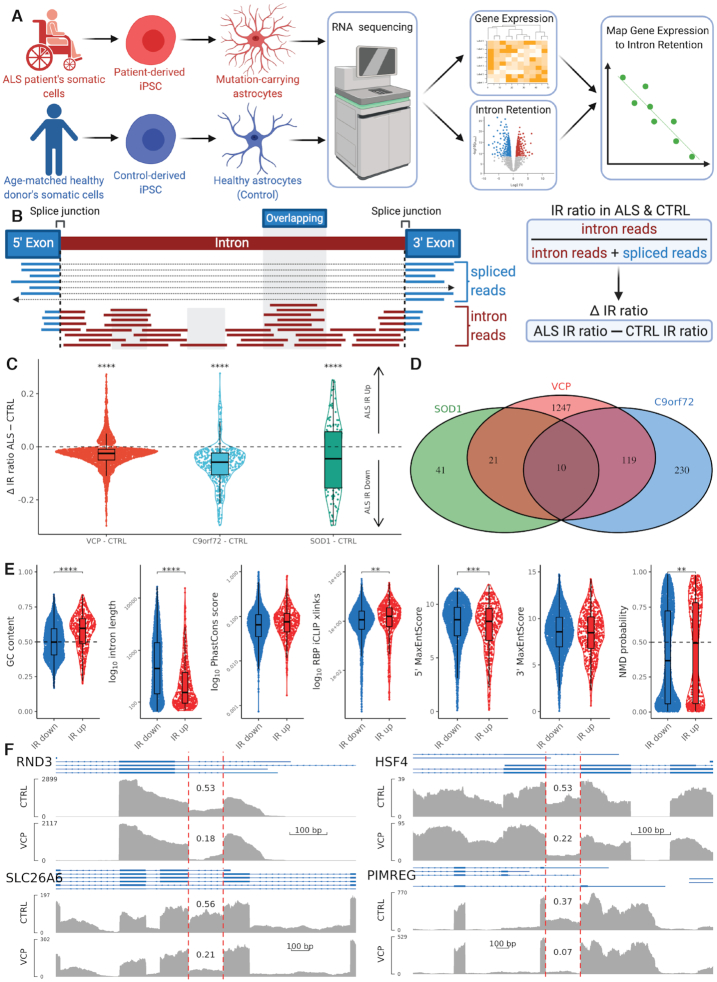
RNA-sequencing reveals loss of intron retention in ALS astrocytes. (A) Schematic depicting human-induced pluripotent stem cells (hiPSC) astrocyte differentiation and fractionation in ALS (red) and control (blue). Astrocytes were subjected to RNA-sequencing and were analysed for differential gene expression and alternative splicing, with a focus on intron retention. We then mapped the spliced-transcript expression and intron retention values of each gene. See Supplementary Figure S1A for stepwise differentiation strategy of iPSC-derived astrocytes. Two hiPSC lines were obtained from two ALS patients with VCP mutations (R155C and R191Q) and two healthy controls. (B) Schematic of IR quantification and differential IR calculation between mutant and control. Median intron coverage is calculated after excluding non-unique multi-mapping reads, overlapping exons (blue) and outliers (highest and lowest 30%) depicted by the shaded regions. Exon and intron read abundance is normalized for feature length. IR ratio is calculated as intron abundance divided by the sum of intron and spliced abundance. Reliable IR event expression is defined as (1) spliced reads mapping across the 3′ and 5′ flanking exons + intron reads > 10 and (2) > 4 reads from across the 3′ and 5′ flanking exons. Delta IR ratio is calculated as mutant minus control IR ratio. Adapted from Wong et al. (36) and Middleton et al. (58). (C) Violin plot showing delta IR ratio in ALS mutants minus control across differential intron retention events. Intron retention was significantly downregulated in VCP (red, n = 2309), C9orf72 (light blue, n = 448) and SOD1 (green, n = 139) astrocytes versus CTRL (one-sample t-test, **** represents P < 0.0001). (D) Venn diagram showing the number of overlapping genes with decreased intron retention events in VCP (red), C9orf72 (blue) and SOD1 (green). Gene overlap exhibiting decreased IR between SOD1 and VCP datasets was 31/76 (40.1%, P = 1.8 × 10−18, hypergeometric test). C9orf72 and VCP overlap was 129 / 347 (37.2%, P = 1.8 × 10−67. Overlapping all three mutants chi-squared P = 0.005. (E) Violin plots showing intron characteristics (GC content; intron length; phastCons conservation score; iCLIP crosslinking with RBPs; 5′ and 3′ Maximum Entropy Scores); and nonsense mediated decay (NMD) probability of upregulated versus downregulated retained introns in ALS mutants (VCP, C9orf72 and SOD1) versus control astrocytes (IR down, n = 2339; IR up, n = 490; **** represents adjusted P values from Wilcoxon test < 0.0001, *** < 0.001, ** P < 0.01). For intron characteristics of individual ALS mutants see Supplementary Figure S4B. (F) Coverage plots of reads per million from VCP mRNA sequencing reads for RND3, SLC26A6, HSF4 and PIMREG genes. Within each are alignment tracks for CTRL (top) and VCP (bottom) astrocytes. Ensembl transcript annotation tracks are shown above the alignment tracks with exons (thick blue boxes) and introns (thin blue arrowed lines). Vertical red dashed lines show the retained intron of interest and the IR ratio is labelled above the retained intron. Y-axis limits for each track are auto-adjusted to the peak exon coverage so that the target feature fills the view and enables easier visual comparison of IR ratios between conditions.